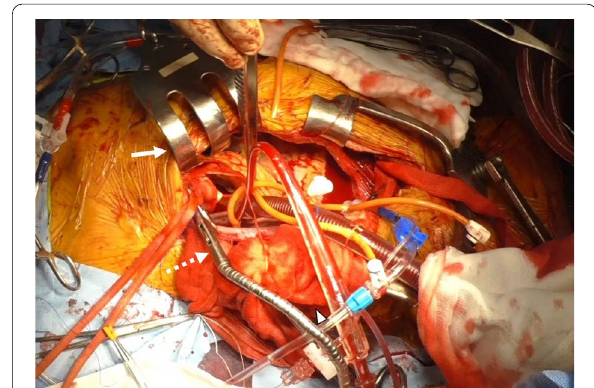
Fig. 4 Securing the operating field. The aorta was cross‑clamped using a flexible aortic clamp (white dotted arrow). A Kent retractor was applied to elevate the sternum (white arrow). The right costal arch was folded back (white arrowhead) and fixed using the